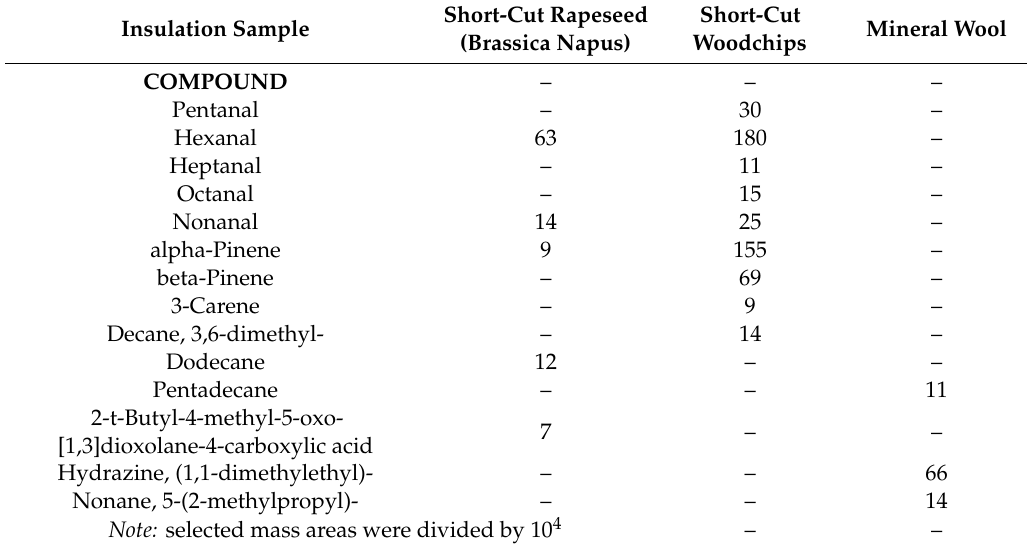
Table 7. Detected VOCs from specific thermal insulation materials—intensities of monitored VOC emissions; intensities detector response for unique